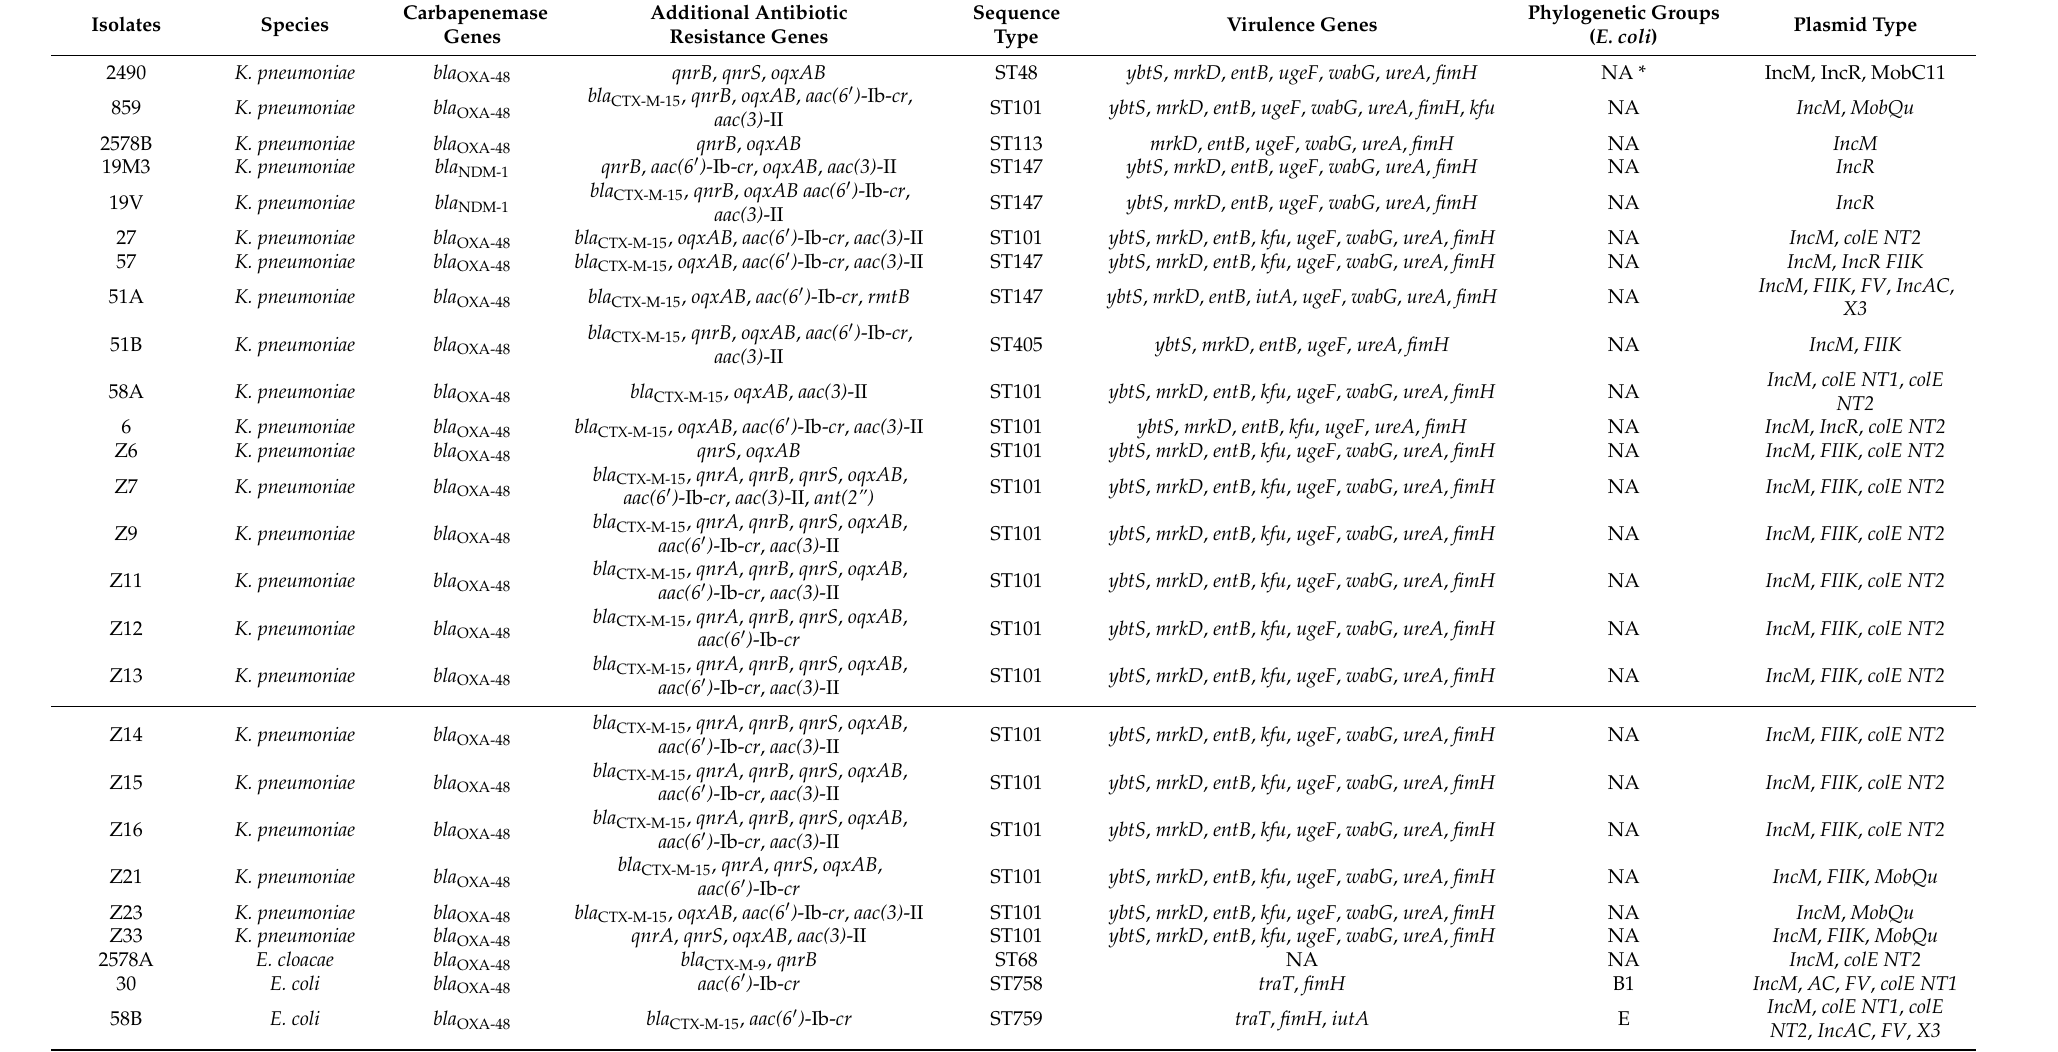
Table 1. Clinical features of carbapenemase-producing isolates obtained in this